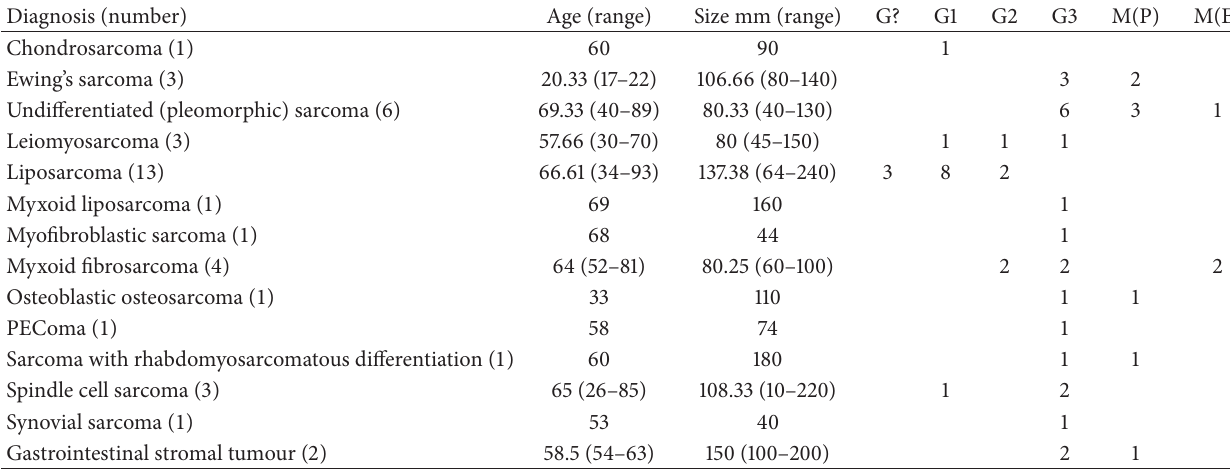
Table 4: Diagnosed sarcomas according to tumour type, grade, and metastatic nature.